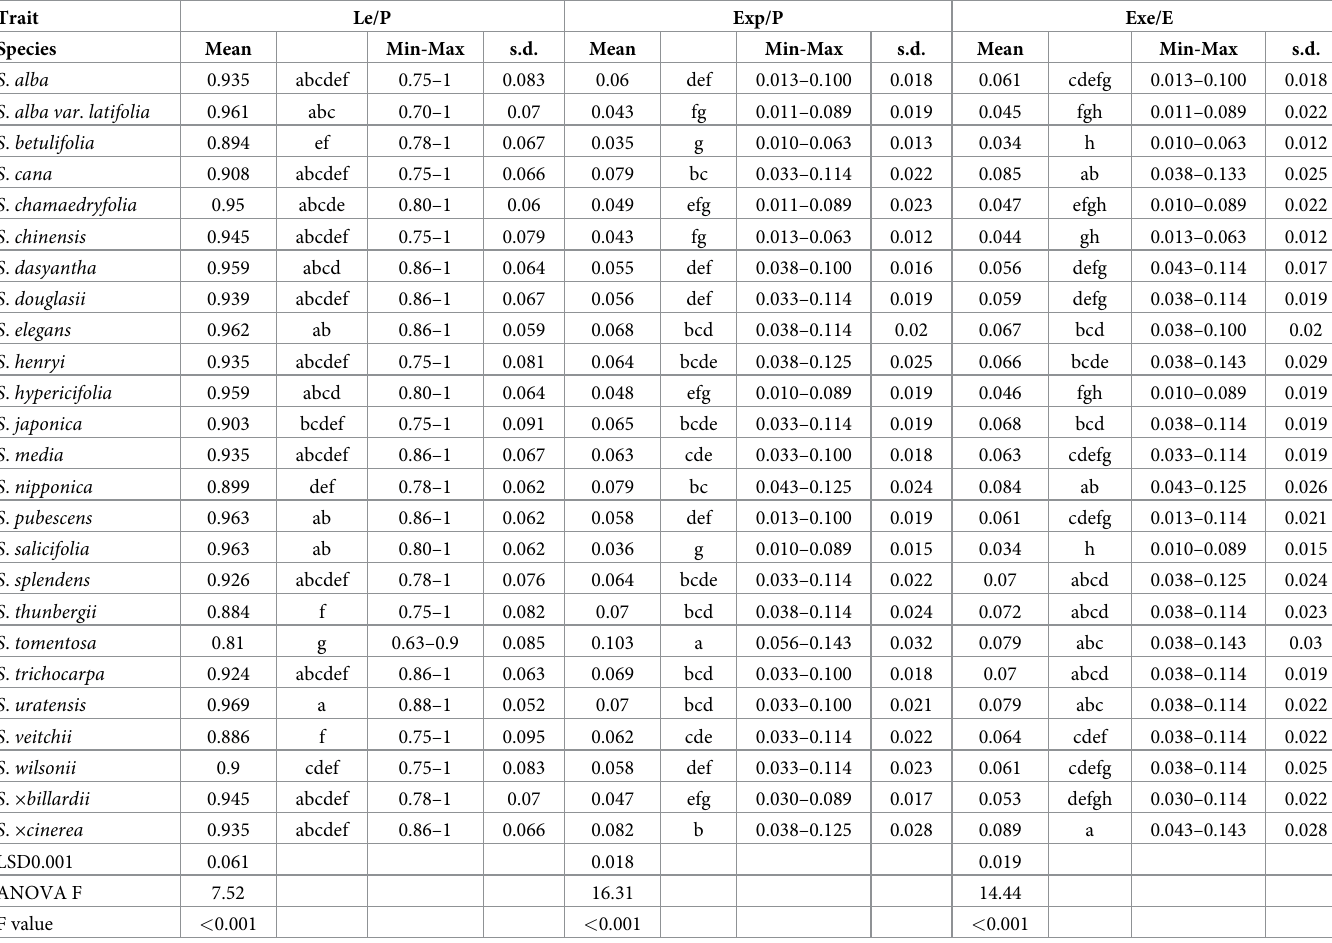
Table 5. Minimal, maximal and mean values as well as coefficients of variation (CV) for Le/P, Exp/P and Exe/E of analyzed